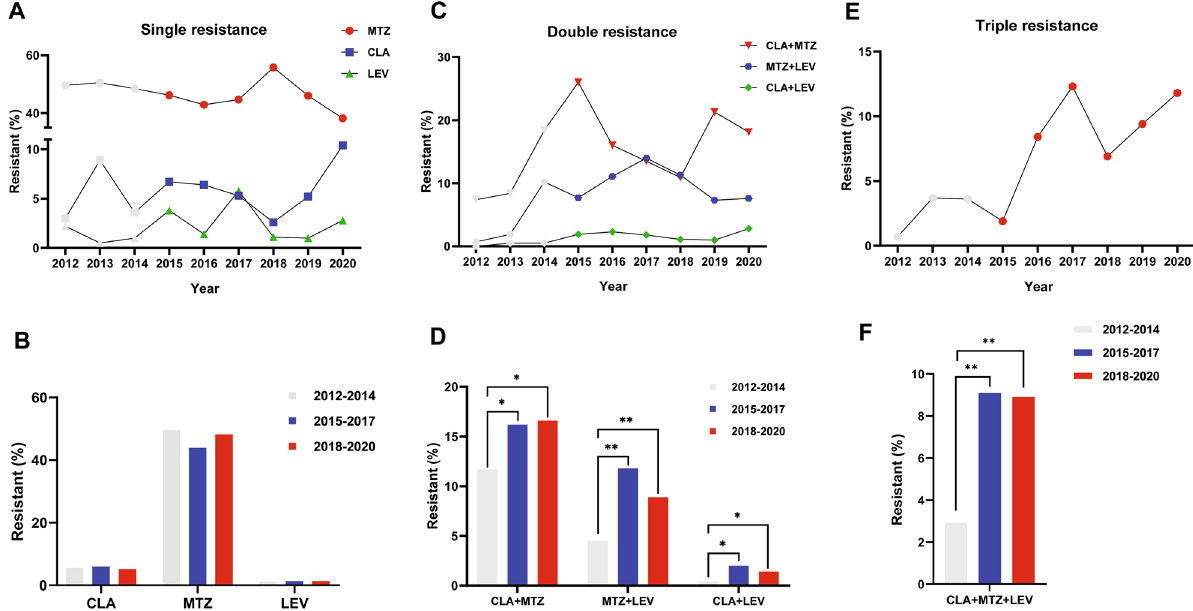
Figure 2. Antibiotic resistance patterns of H. pylori to clarithromycin, metronidazole and levofloxacin according to year. ( A ) Single resistance to clarithromycin, metronidazole and levofloxacin annually from 2012 to 2020. ( B ) Single resistance to clarithromycin, metronidazole and levofloxacin in different time periods, 2012– 2014, 2015–2017 and 2018–2020. ( C ) Double resistance annually from 2012 to 2020. ( D ) Double resistance in different time periods, 2012–2014, 2015–2017 and 2018–2020. ( E ) Triple resistance annually from 2012 to 2020. ( F ) Triple resistance in different time periods, 2012–2014, 2015–2017 and 2018–2020. CLA, clarithromycin; MTZ, metronidazole; LEV, levofloxacin. * P < 0.05, ** P < 0.01.